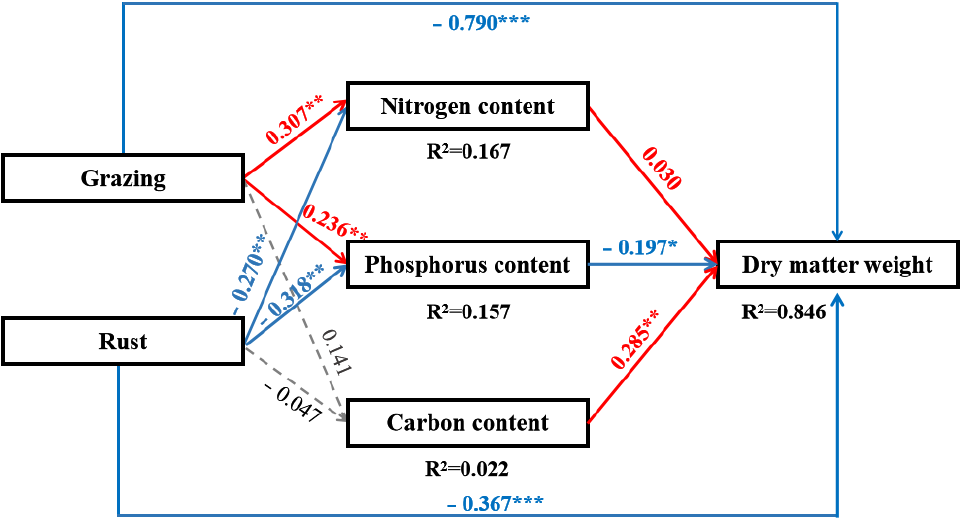
Figure 8. Final results of structural equation modeling (SEM) analysis for the effects of grazing and rust on the dry matter of Leymus chinensis in 2015 and 2016. Red arrows, evidence for positive relationships; blue arrows, evidence for negative relationships; gray arrows, insufficient statistical evidence for path coefficients ( p > 0.05). Width of the arrows shows the strength of the causal relationship, and the number adjacent to arrows are standardized path coefficients, which reflect the effect size of the relationship; asterisks indicate statistical significance (***, p < 0.001; **, p < 0.01; *, p < 0.05). The proportion of variance explained (R 2 ) appears alongside each response variable in the model. The final model adequately fitted the data: χ 2 = 249.059, Df = 4, P = 0.104, GFI =